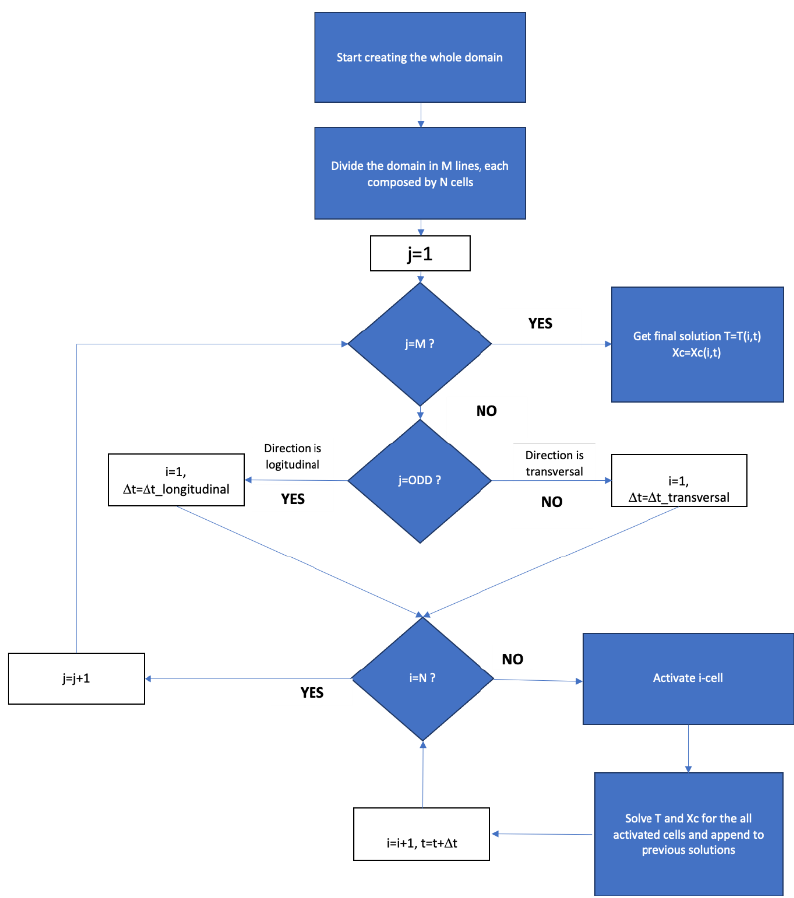
Figure 4. Schematic representation of the process simulation flow